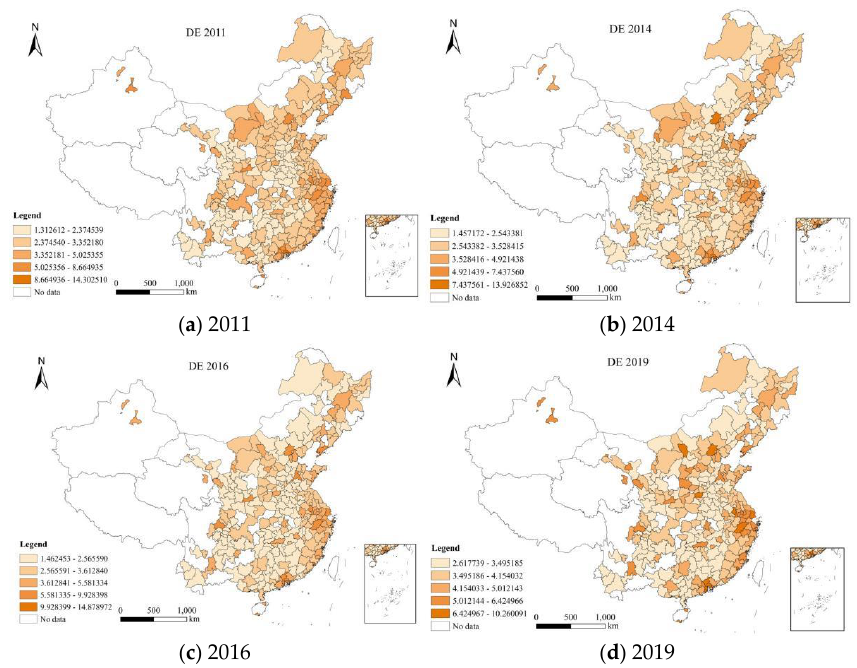
Figure 2. Digital economy of 275 cities in China in (a)2011, (b)2014, (c)2016 and (d)2019.